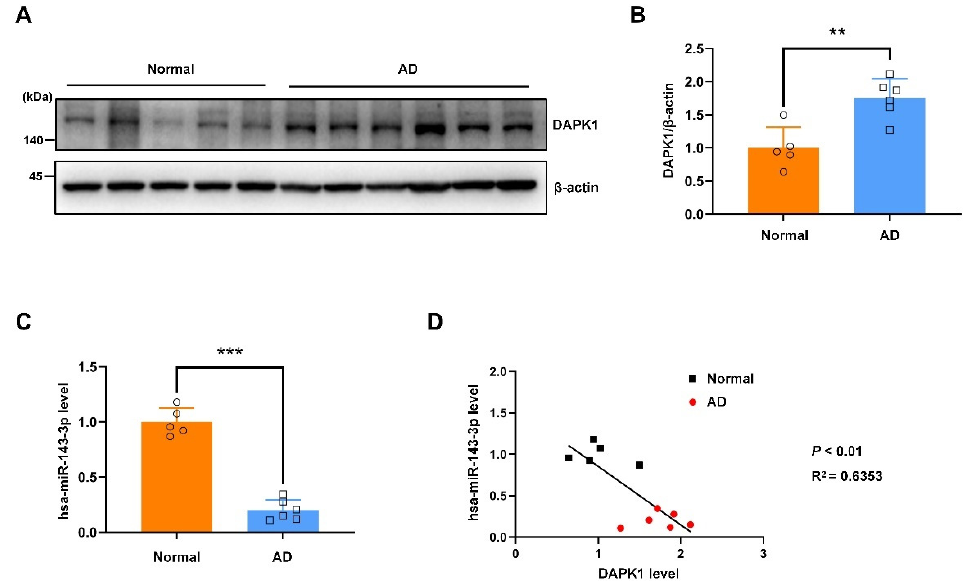
Figure 9. The hsa-miR-143-3p levels are decreased and inversely correlated with DAPK1 expression in the hippocampus of AD patients. ( A , B ) Hippocampal tissues of AD patients and age-matched healthy controls were harvested, and the levels of DAPK1 were analyzed by immunoblotting. ( C ) The hsa-miR-143-3p levels in AD and normal control brain tissue samples were analyzed by qRT-PCR using U6 small nuclear RNA as an endogenous control. ( D ) Linear regression analysis was performed to evaluate the correlation between the DAPK1 and hsa-miR-143-3p levels (R 2 = 0.6353; Pearson’s correlation coefficient). Relative quantification was performed using ImageJ software, and the results are presented as a histogram. The data (circles and squares) are presented as the mean ± SD of three independent experiments (** p < 0.01, *** p < 0.001).